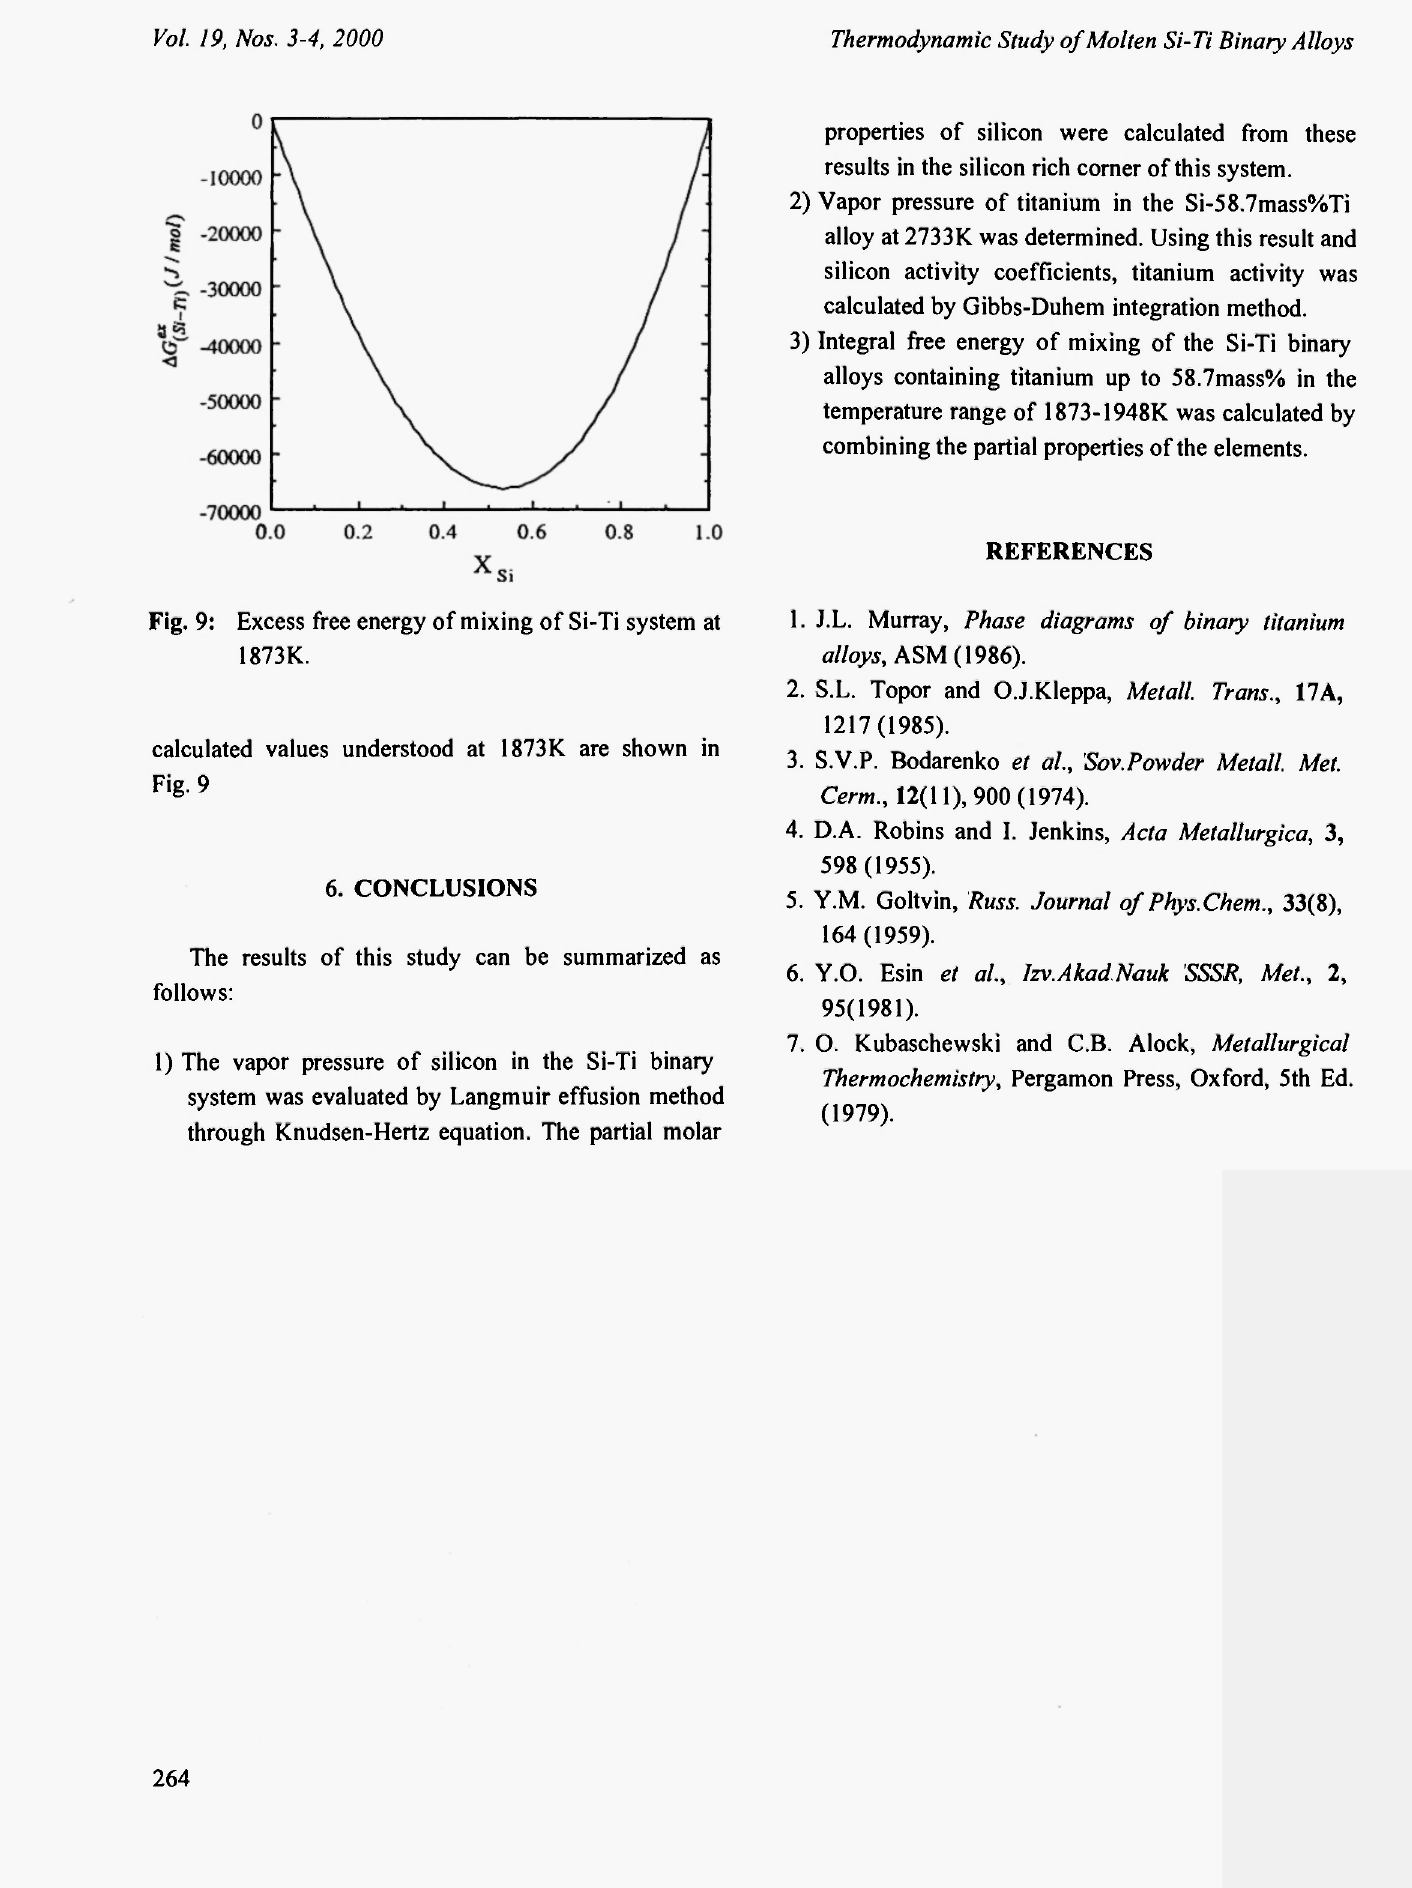
Fig. 9: Excess free energy of mixing of Si-Ti system at